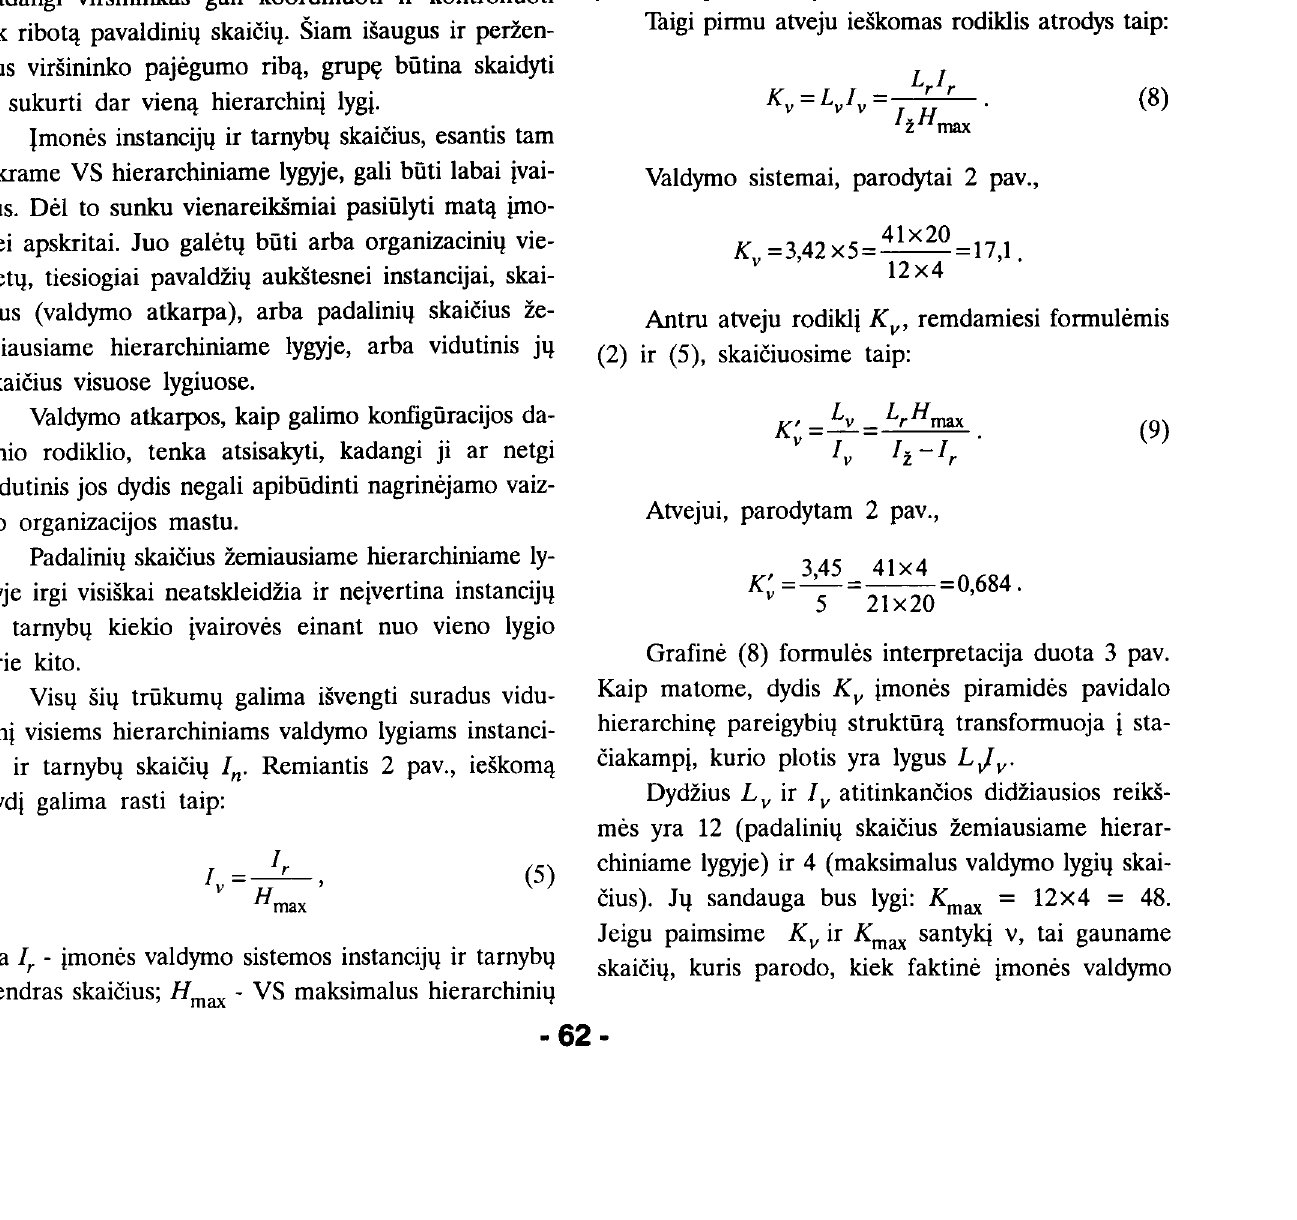
figflracijos rodiklio reikSmes. To isvengsime, jeigu api bendrinanCia konfigflracijos dimensija parinksime ne j4 sandaugtt, o